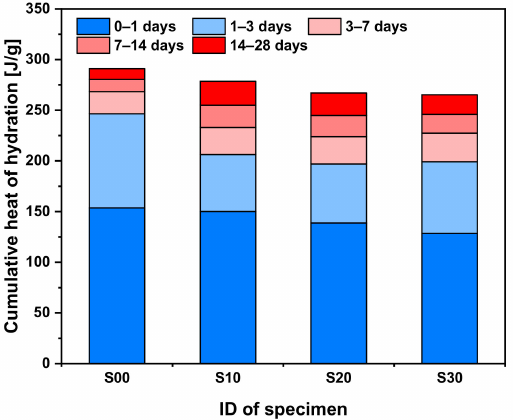
Figure 4. Cumulative heat of hydration of cement mortars blended with SF.